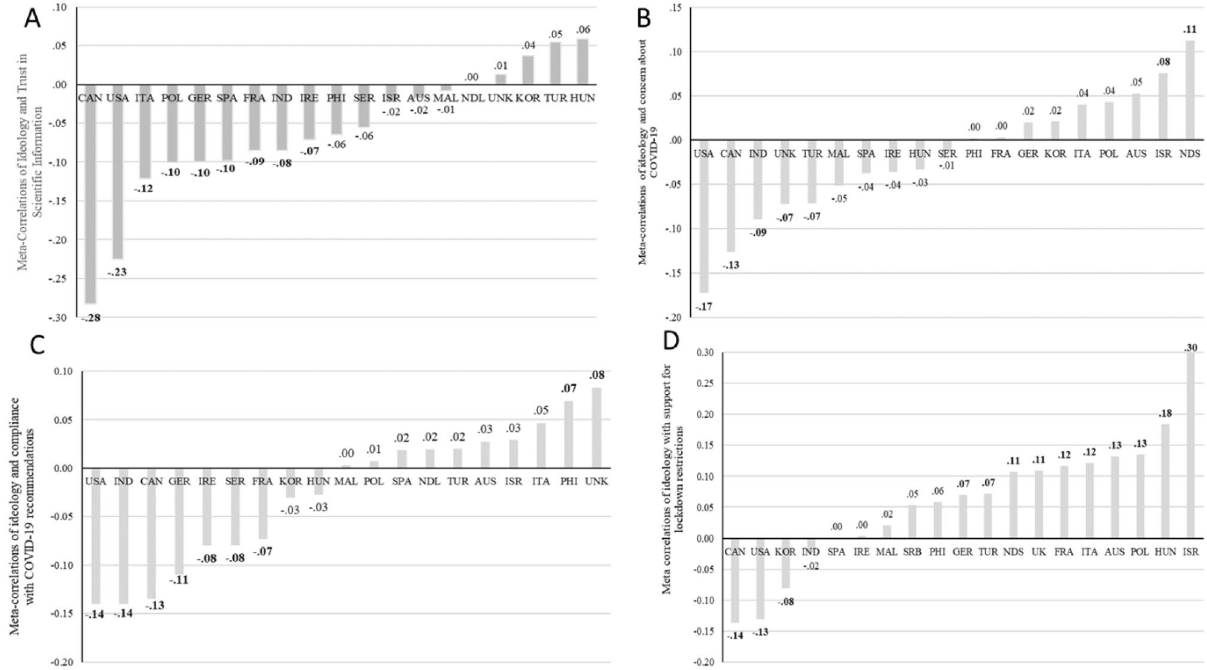
Figure 3. Visual depiction of meta-correlations between conservative/right wing political ideology and ( A ) trust in scientific information about coronavirus across the three cross-sectional waves for each country; ( B ) concern about contracting the coronavirus across the three cross-sectional waves for each country; ( C ) compliance with recommended preventative behaviors to avoid contracting or spreading the coronavirus across the three cross-sectional waves for each country; ( D ) support for lockdown restrictions across the three cross-sectional waves for each country. Figures were constructed in Microsoft Excel using the same spreadsheet in which the meta-correlations were generated. Note: Bolded values depict significant meta-correlations for all sub-figures. Values > 0.08 are significant at p < 0.05, values > 0.09 are significant at p < 0.01, and values > 0.10 are significant at p <